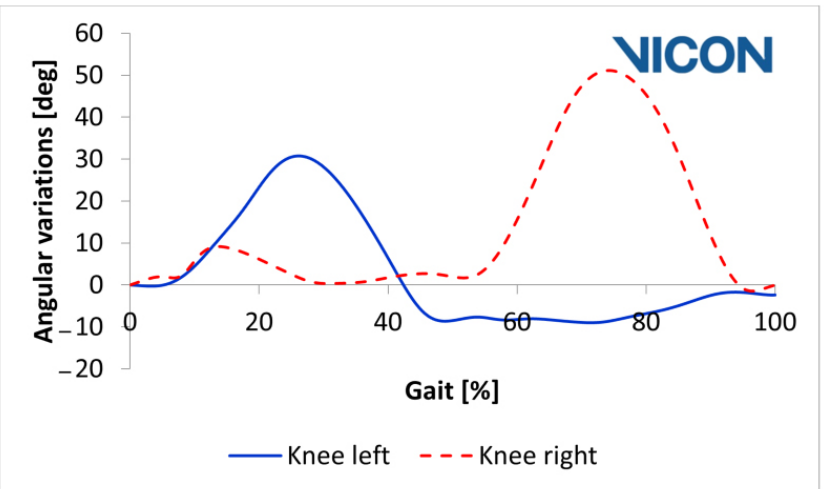
Figure 3. Hip joints angular variations during one gait vs. time.